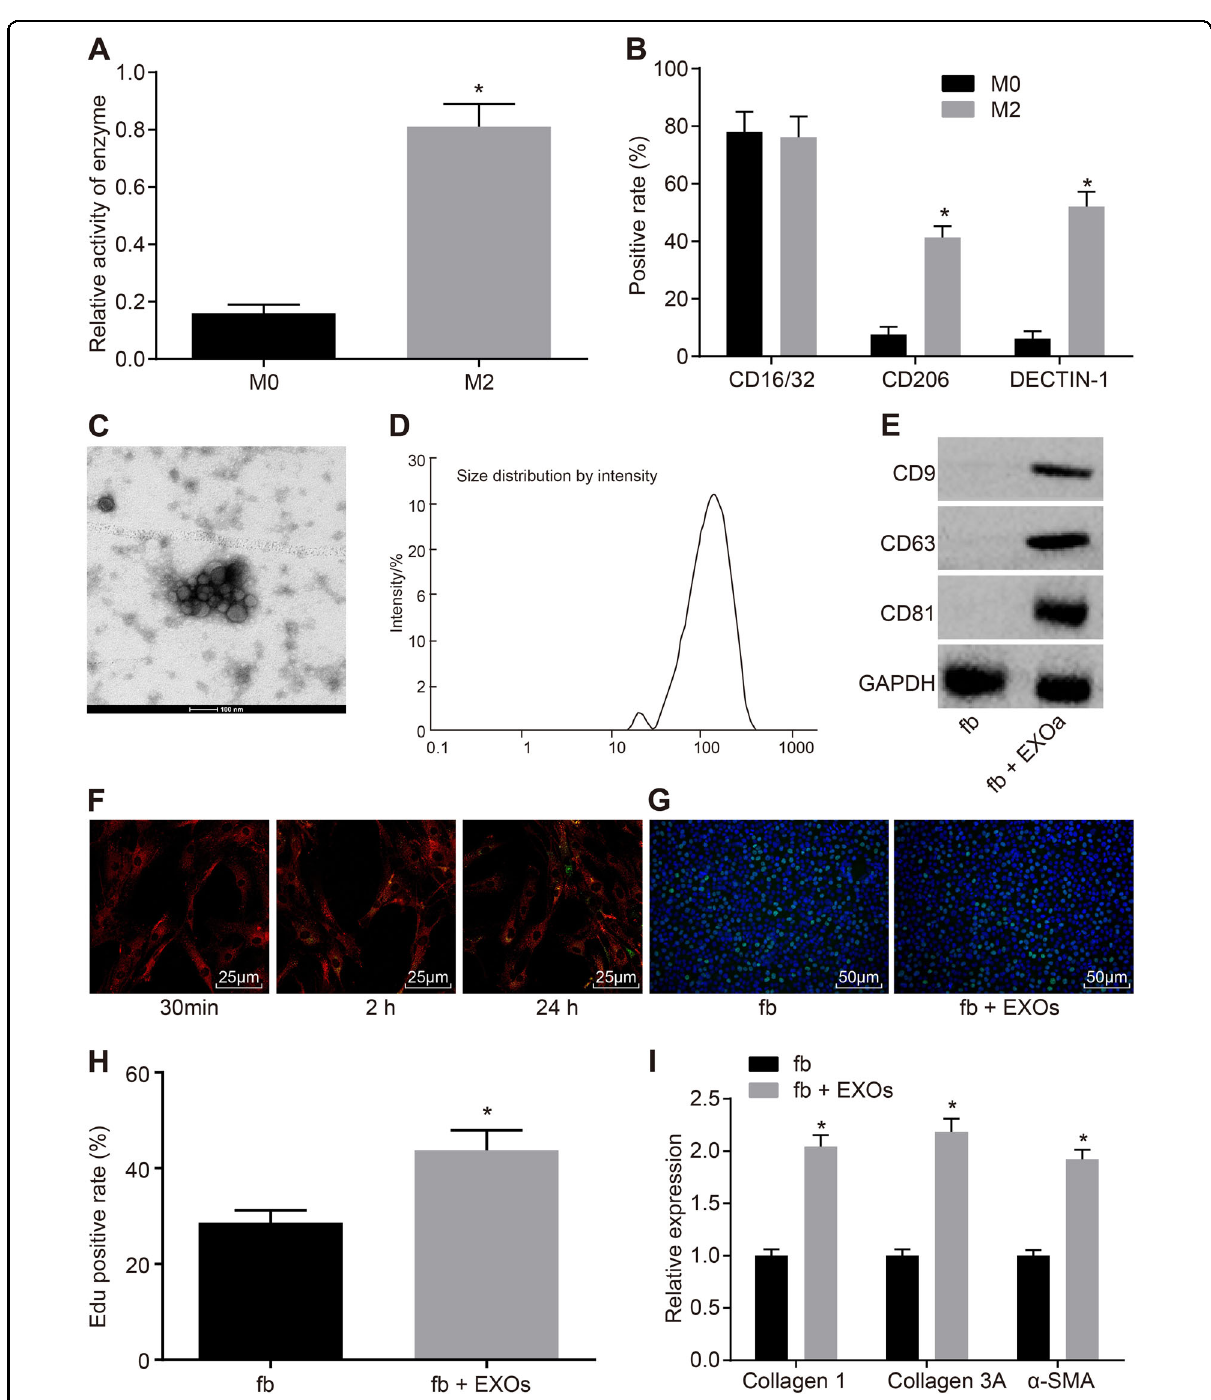
Fig. 5 M2 macrophage-secreted exosomes promote pulmonary interstitial fi broblast proliferation . a Arg-1 activity of M0 and M2 macrophages, * p < 0.05 vs . M0 macrophages. b Positive expression rates of CD9, CD63 and CD81 in M0 and M2 macrophages, * p < 0.05 vs . M0 macrophages. c Exosome morphology observed by TEM. D, Exosome particle size analysis. e The protein levels of the exosomal markers CD9, CD63 and CD81 examined by western blot analysis. f The internalization of M2 macrophage-secreted exosomes by pulmonary interstitial fi broblasts at different time points; green indicates PKH67-labeled exosomes, and red represents pulmonary interstitial fi broblasts, bar = 25 μ m. g , Edu labeling to examine the proliferation of pulmonary interstitial fi broblasts after a coculture with exosomes (200 × ). H, Quanti fi cation of the results in G. * p < 0.05 vs . pulmonary interstitial fi broblasts. I, Expression of Collagen 1 A, Collagen 3 A and α -SMA in pulmonary interstitial fi broblasts after a coculture with exosomes, as measured by RT-qPCR . * p < 0.05 vs . pulmonary interstitial fi broblasts. Arg-1, arginase 1; EdU, 5-ethynyl-2 ’ -deoxyuridine; α -SMA, α -smooth muscle actin; and RT-qPCR , reverse transcription quantitative polymerase chain reaction. The results were measurement data and were analyzed using an unpaired t test. The results are expressed as the mean ± standard deviation. The experiment was conducted in